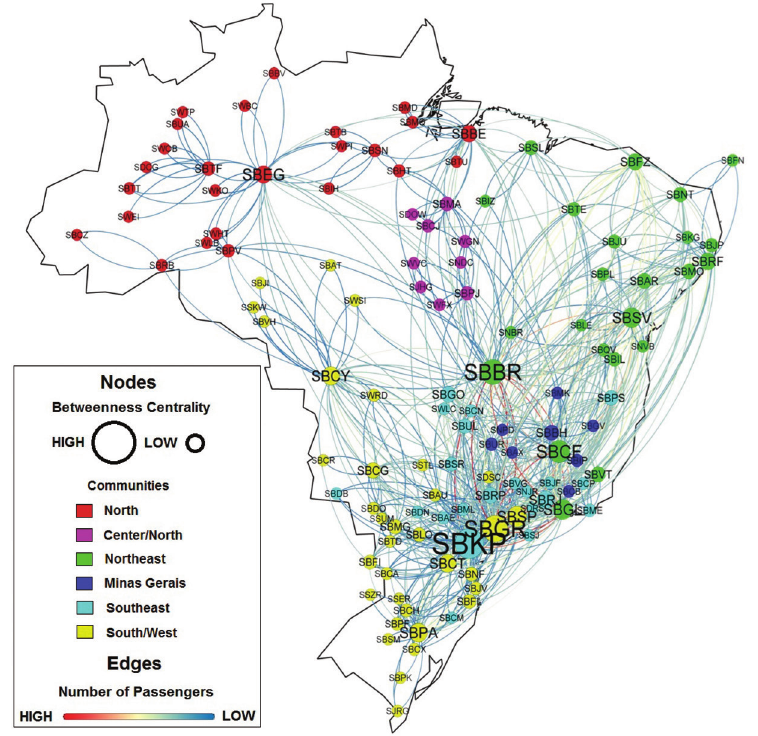
Figure 2 - Airports grouped by different communities. For interpretation of the refe- rences to color in this figure, the reader is referred to the web version of this article.